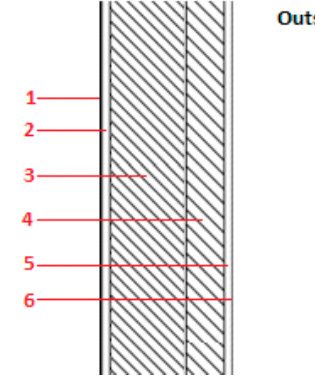
Figure 1. A cross-section of the external wall of the building in the plant in the present state (layers 1–6 described in text).